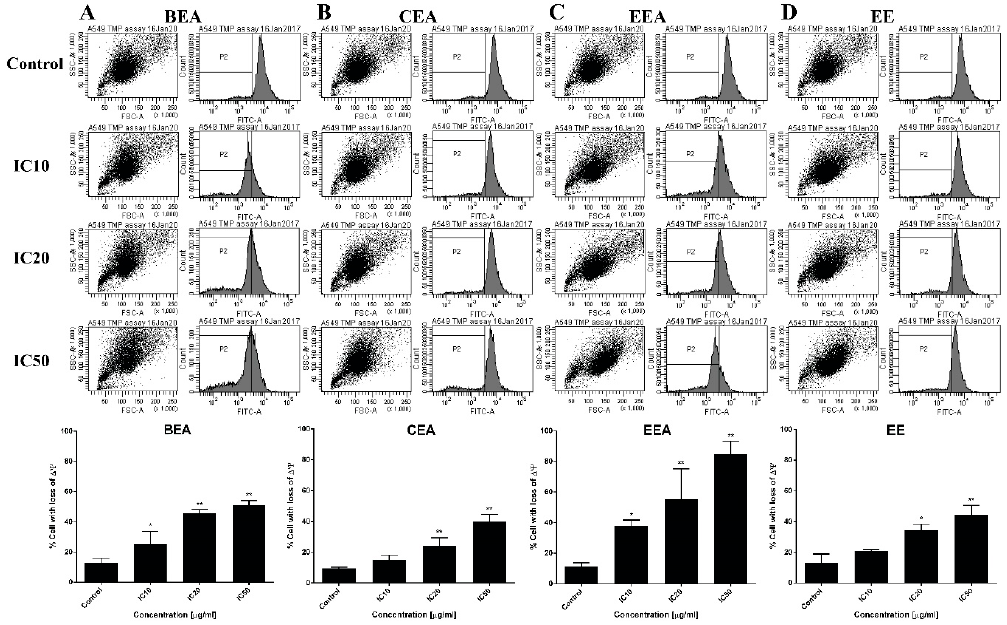
Figure 7. The effective extracts induced ∆Ψ m reduction in A549 cells. Histograms (upper) show